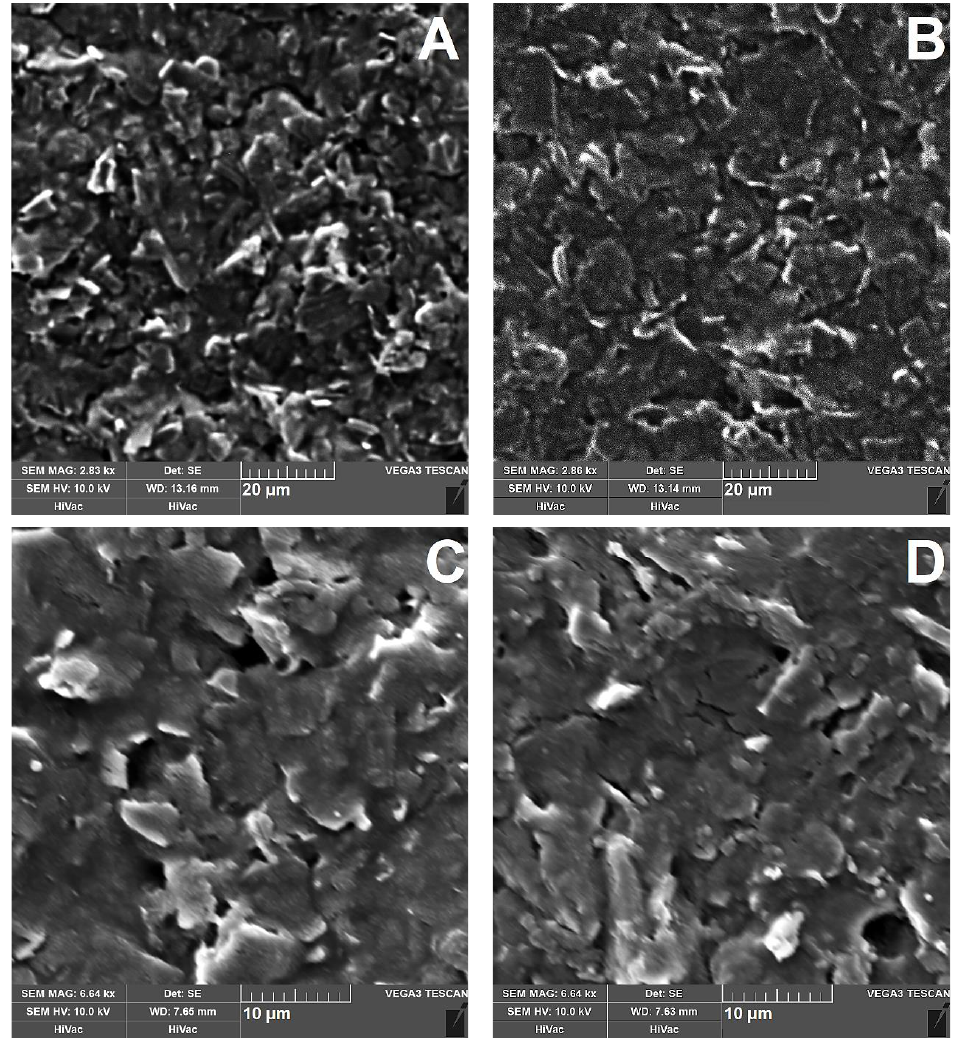
Figure 4. Typical SEM images (~2.85 × 10 3 magnification) of bare SPCE (type DRP-C110; ( A )), SCPE covered with thin layer of poly-vanillin ( B ), SEM images (~6.64 × 10 3 magnification) of SPCE/PV-ALP ( C ) with SPCE/P4HB-TYR ( D